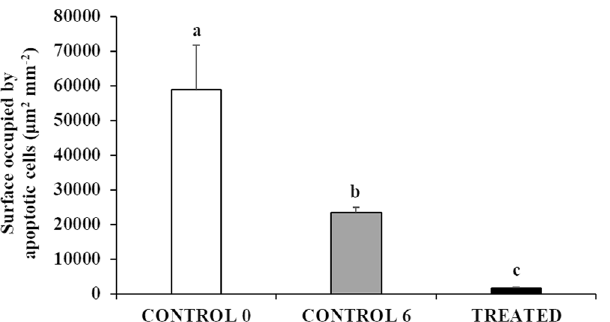
Figure 8. Changes in mean (± sd) surface occupied by apoptotic germ cells in untreated (CONTROL 0, n = 5), treated with saline solution for 6 weeks (CONTROL 6, n = 9) and treated with rFsh for 6 weeks (TREATED, n = 4) juvenile meagre males. Different letters represent statistically significant differences (ANOVA; P <